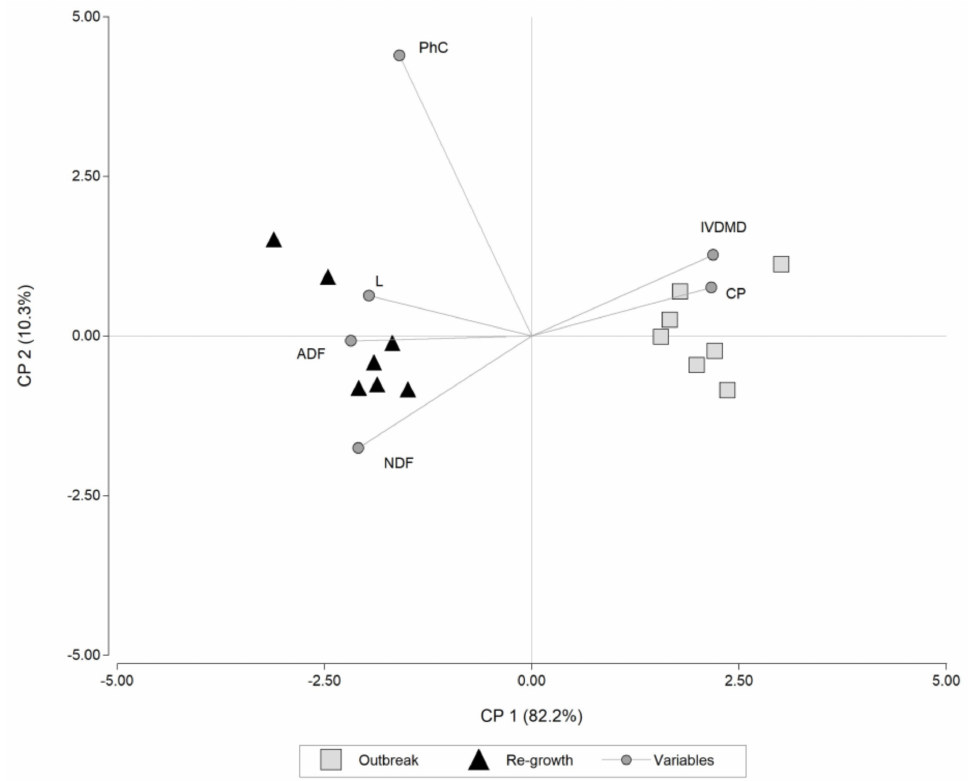
Figure 2. Biplot of the principal components 1 (CP 1) and 2 (CP 2) explaining 92.5% of the varia- tion: weeping lovegrass genotypes at the outbreak and re-growth stages, respectively. PhC: phy- tolith content, CP: crude protein, L: lignin, NDF: neutral detergent fiber, ADF: acid detergent fiber, IVDMD: in vitro dry matter